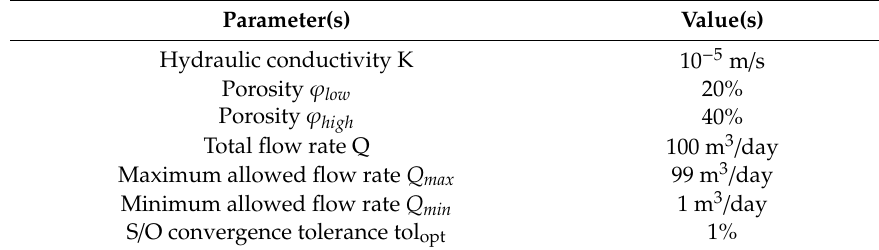
Table 1. Model and numerical algorithm parameters used in the test problems for simulation-based optimization (S / O)